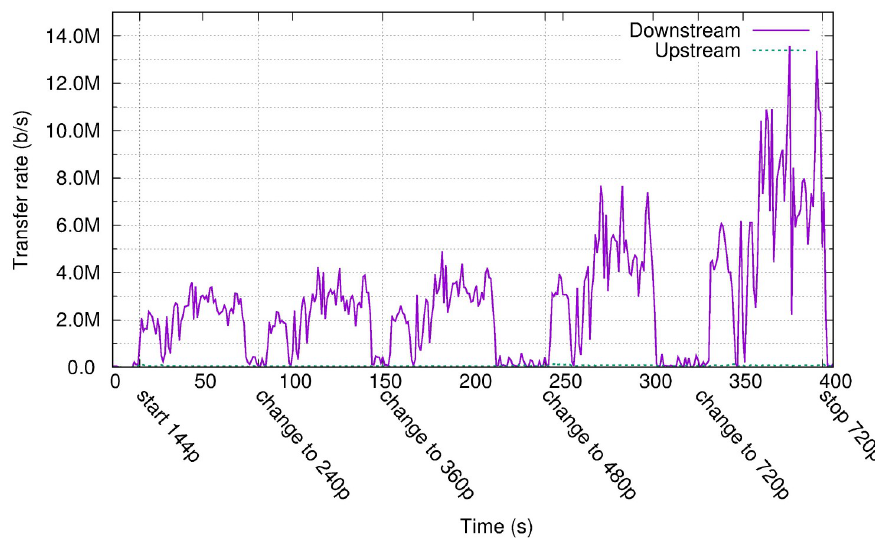
Fig 4. Transfer rate for the video profile in Amazon WorkSpaces with different video